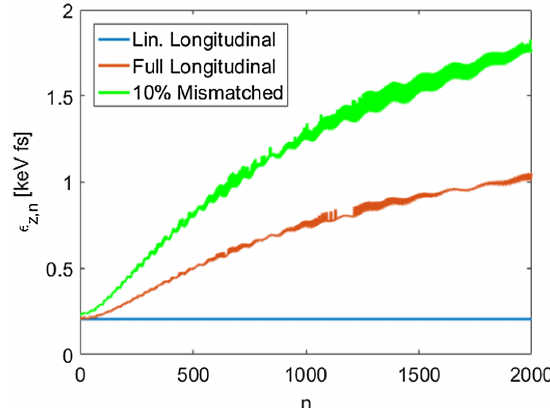
FIG. 10. Longitudinal emittance evolution for a linearly matched Gaussian beam in linearized fields, with the full fields, and with 10% excess energy